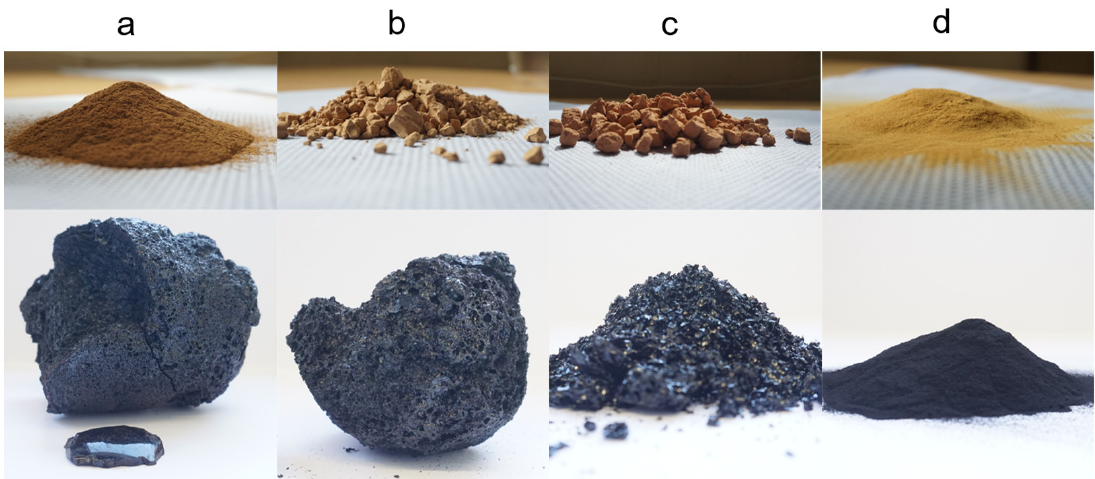
Figure 4. Original lignin and solid pyrolysis residue: ( a ) PKL; ( b ) SOSL; ( c ) BOSL; ( d ) LS.